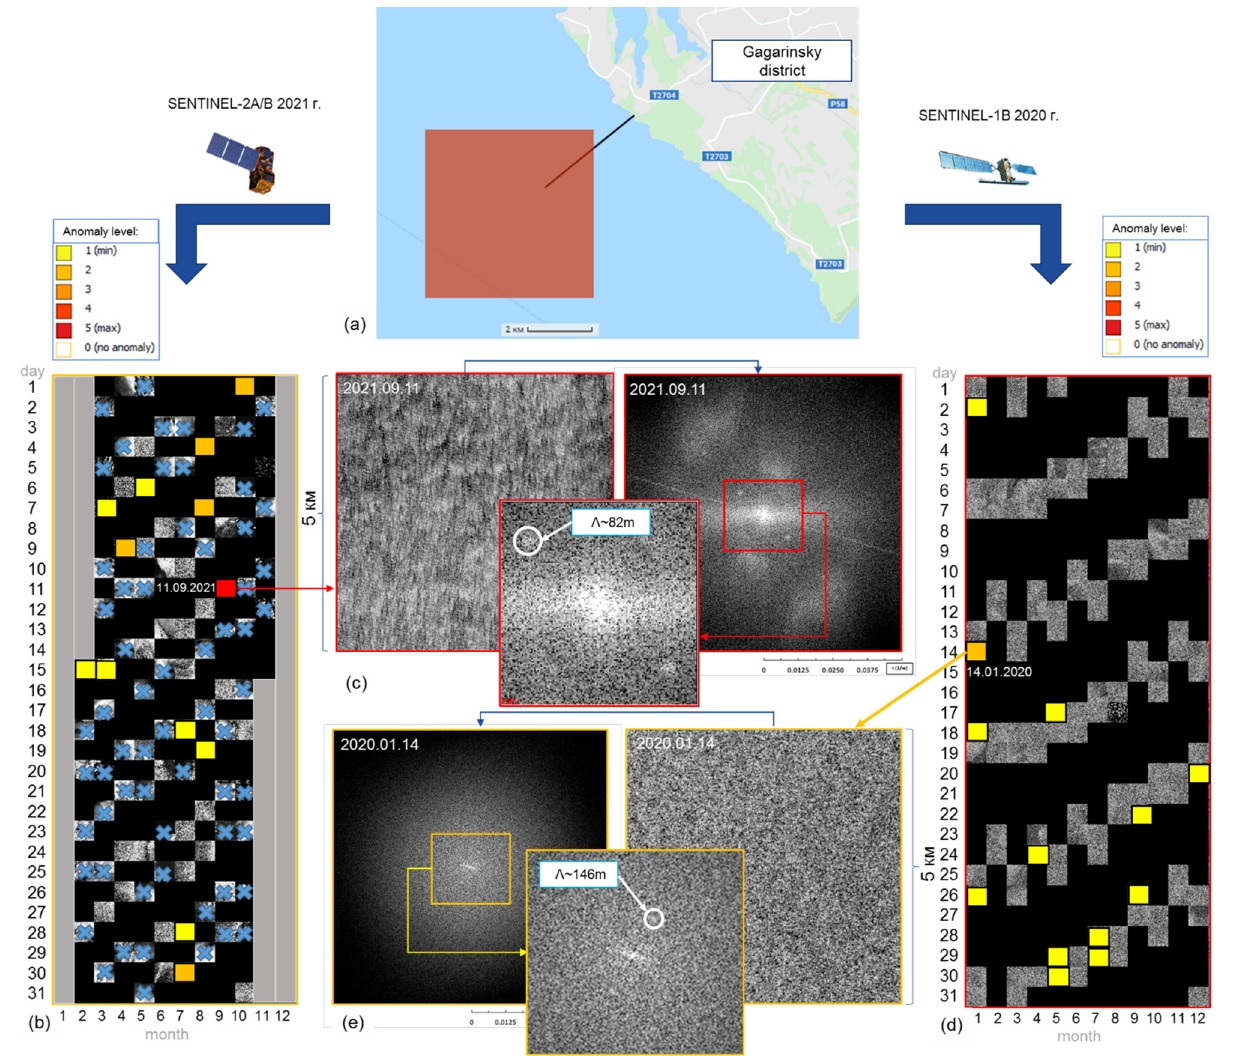
Figure 5. Example results of spatial spectral processing of medium-resolution satellite images, performed using a regular time grid: ( a ) the studied water area; ( b , d ) mosaics of fragments of multi-temporal images obtained by the Sentinel-2A/B multispectral camera ( b ) and the Sentinel-1B radar ( d ) with superimposed marks of detected anomalies (blue crosses—cloudiness); ( c , e ) example fragments of satellite images and their corresponding two-dimensional spatial spectra with the most intense manifestations of submerged wastewater discharge.